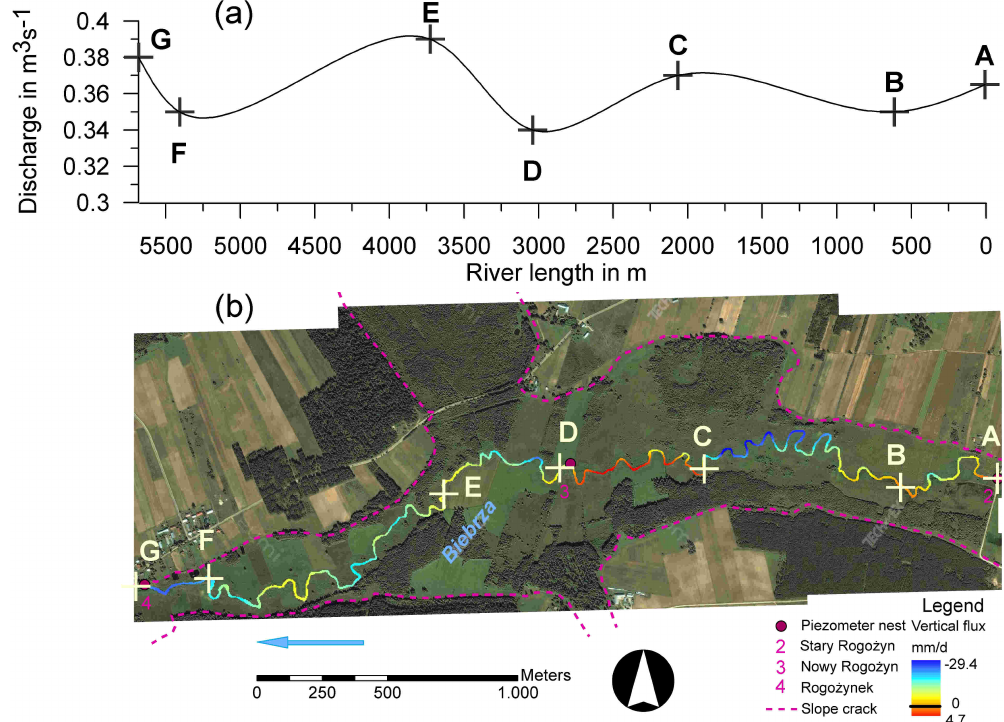
Fig. 8. (a) Surface water discharge measurements A–G along the river section according to De Doncker et al. (2009). (b) Spatial interpolation of the point estimates of the transient simulation on a reach scale indicated as coloured band. The location of the surface water measurements A–G are indicated by crosses. Orthophotomap source: